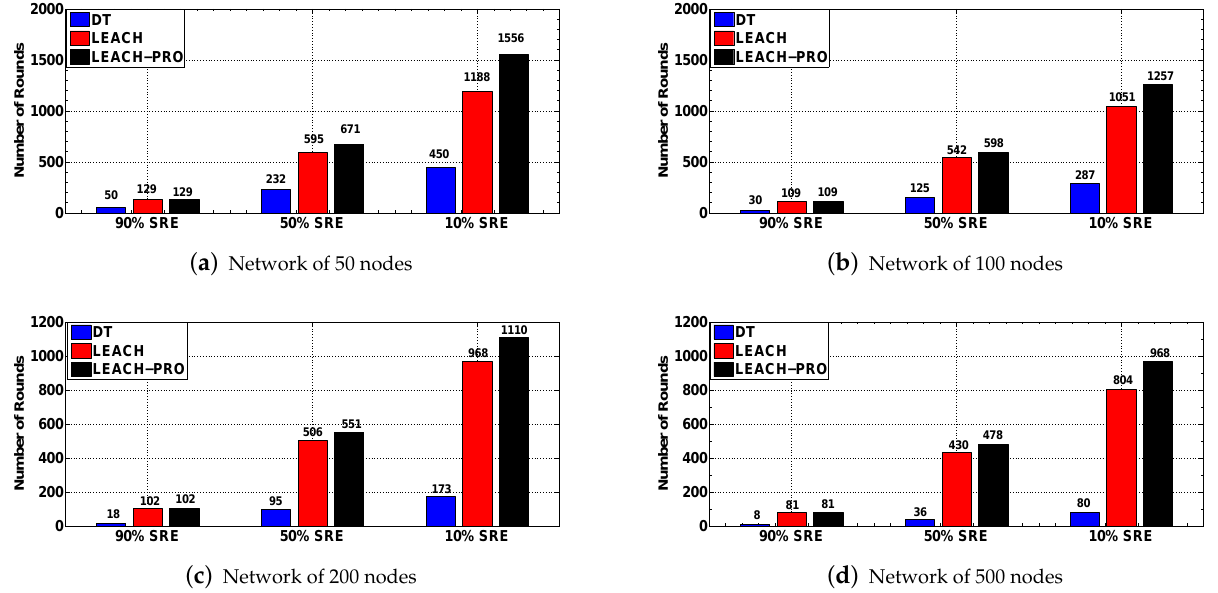
( c ) Network of 200 nodes ( d ) Network of 500 nodes Figure 14. Energy consumption evolution under varying network densities. Network of ( a ) 50, ( b ) 100, ( c ) 200, ( d ) 500